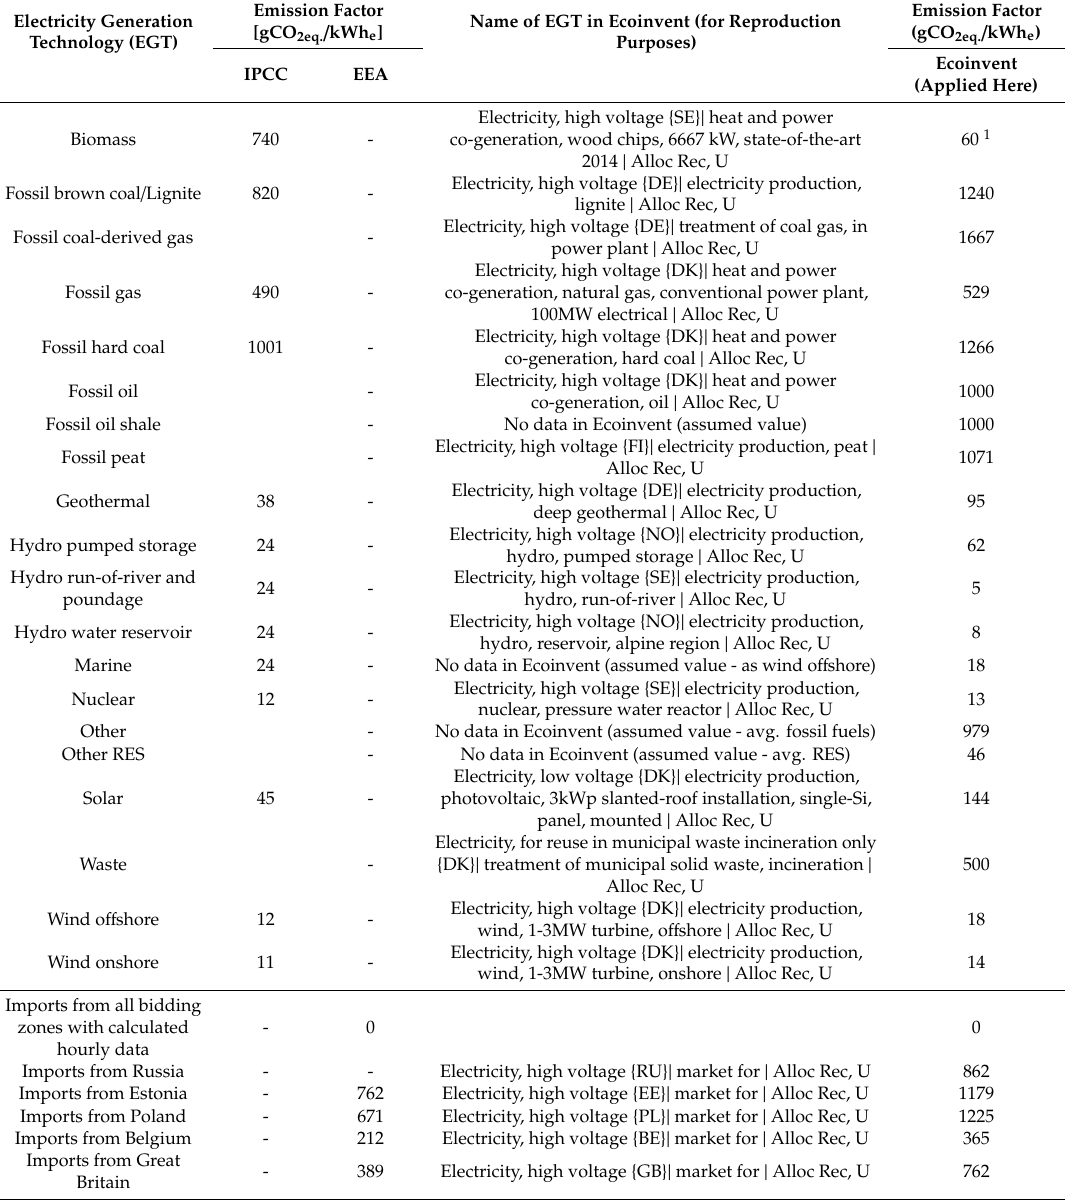
Table A1. Comparison of CO 2 factors per electricity generation technology (EGT) from di ff erent references